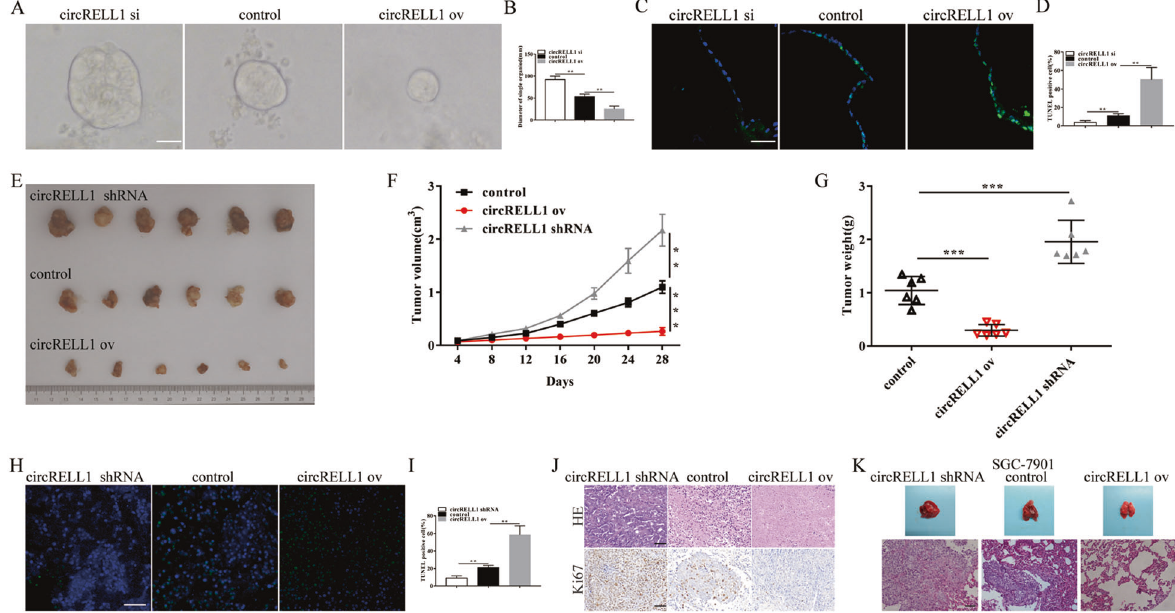
Fig. 5 Enhanced circRELL1 suppresses GC organoids proliferation and represses tumor growth, and metastasis in vivo. A , B Representative results of human GC organoids culture after circRELL1-overexpressing plasmid, circRELL1 shRNA, or control transfection (scale bar: 25 μ m). C , D Assessment of the apoptosis of organoids cocultured with different treatments by TUNEL assays. E Xenograft tumors under different treatments. F , G Analysis of tumor size and weight after different treatments. H , I Assessment of the apoptosis of the xenografts by TUNEL assays (scale bar: 50 μ m). J Representative results of HE staining of the specimen and assessment of the Ki-67 protein levels in the xenografts by IHC analysis (scale bar: 50 μ m). K Representative images of pulmonary metastasis and HE staining of specimen (scale bar: 50 μ m). Results are presented as mean ± SD of three independent experiments. ** P < 0.01, *** P < 0.001.